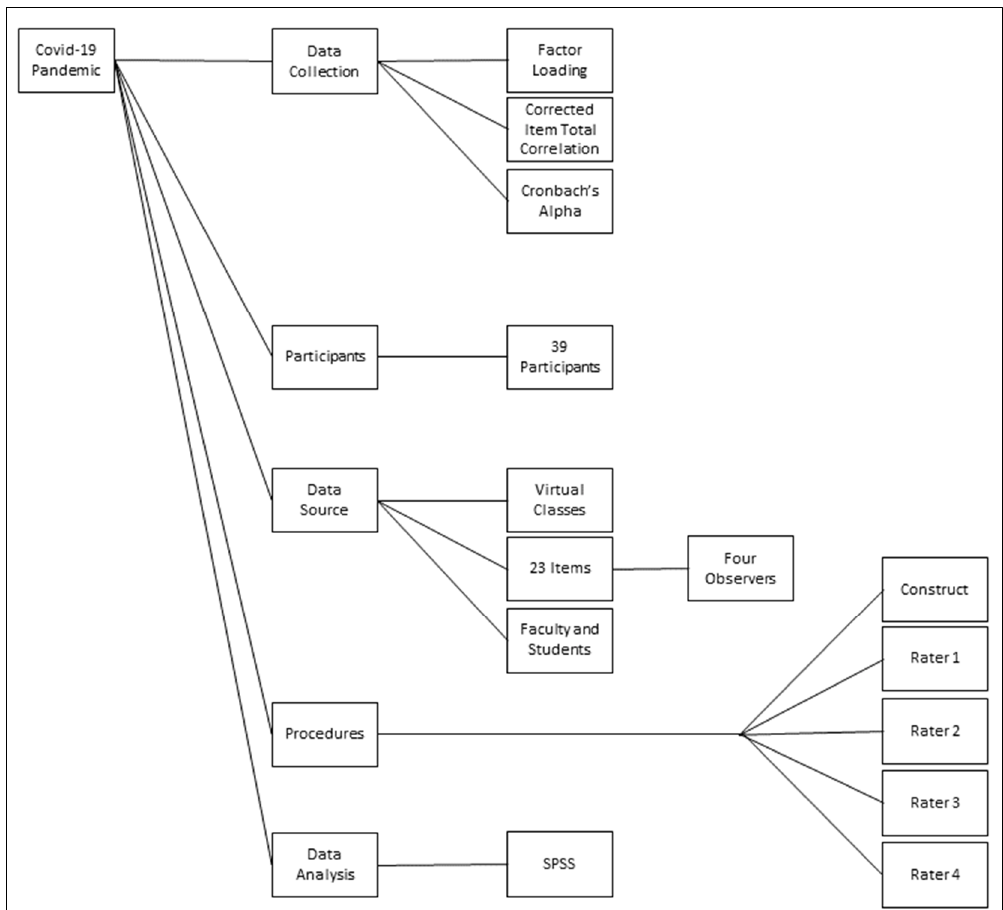
Figure 1. Methods of the